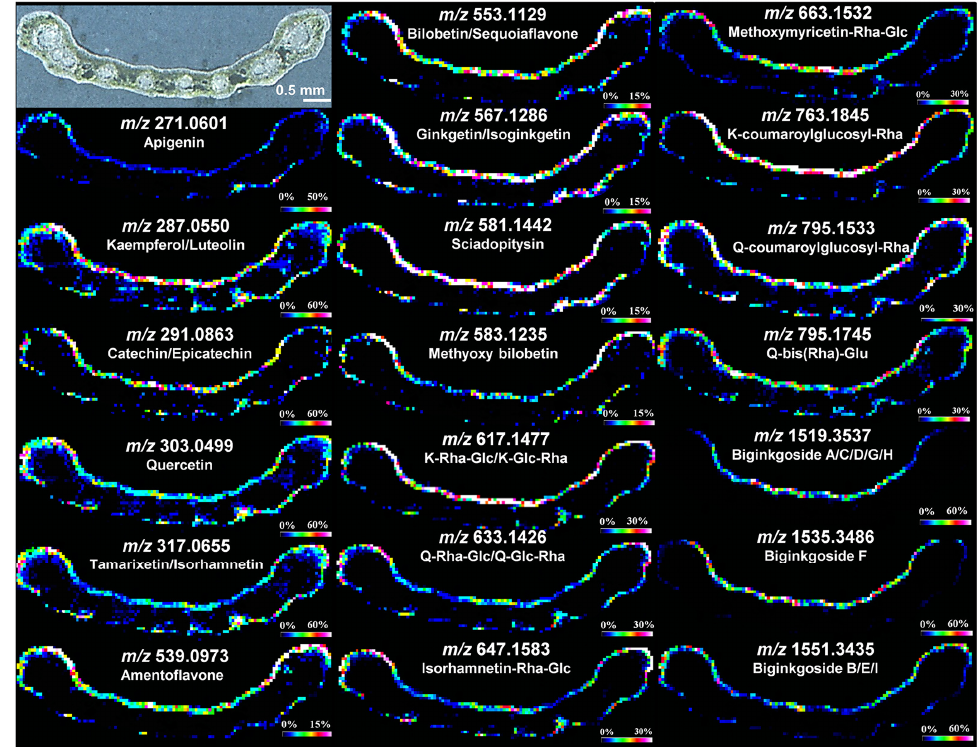
Figure 3. Cross-sections of ginkgo leaves imaged in positive mode MALDI showing images of selected flavonoid ions, including aglycones (m/z 271.0601–317.0655), biflavonoids (m/z 539.0973–583.1235), glycosides (m/z 617.1477–795.1745) and biginkgosides (m/z 1,519.3537–1,551.3435) in ginkgo leaf. Ion images were recorded with a step size of 50 µm. The mass accuracy was less than 2 ppm and a bin width of m/z = ±5 ppm was used for image generation. Images represent the protonated, sodium and potassium adducts of metabolites. Glc: glucoside/glucosyl moiety; K: kaempferol; Rha: rhamnoside/rhamnosyl moiety; Q: quercetin. Figure reproduced with permission from Li et al. [101].